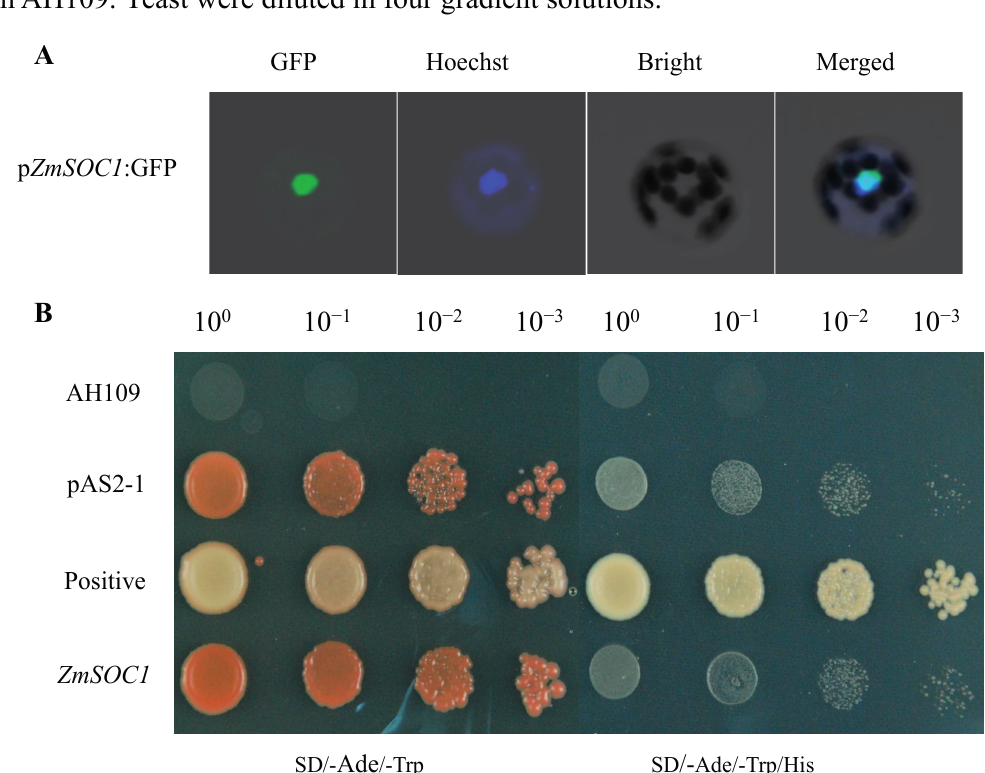
Figure 3. Subcellular localization and yeast transcriptional activation analysis of